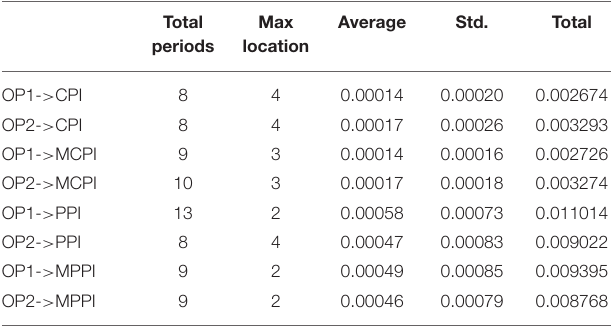
TABLE 2 | Statistical description of accumulated response without a monetary